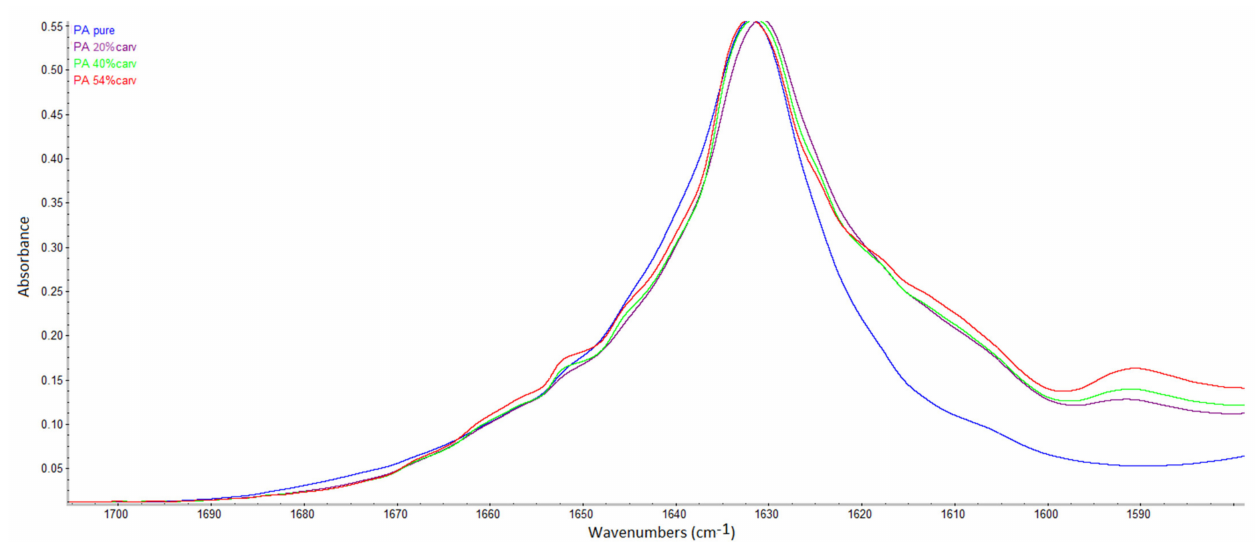
Figure A6. C=O stretching vibration band in neat and carvacrol-impregnated polyamide